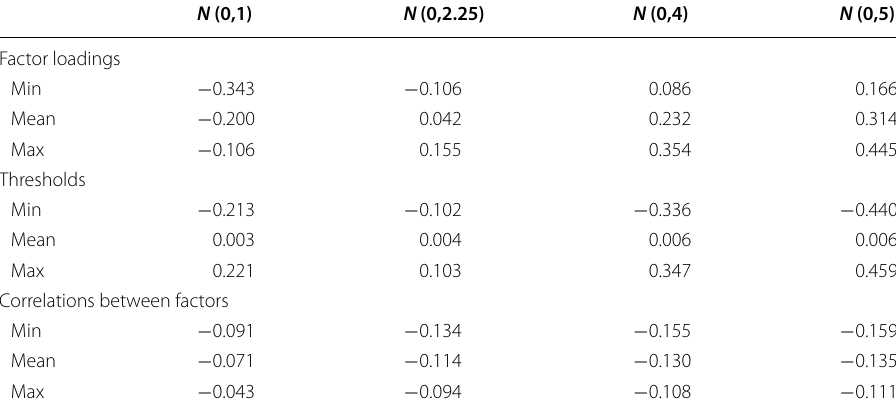
Table 2 Parameter bias in the simulation